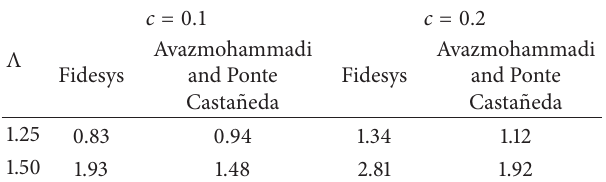
Table 2: The first Piola-Kirchhoff shear stress in a fibrous elas- tomeric composite as a function of shear strain. A comparison between the Fidesys computations and the results of Avazmoham- madi and Ponte Casta˜neda